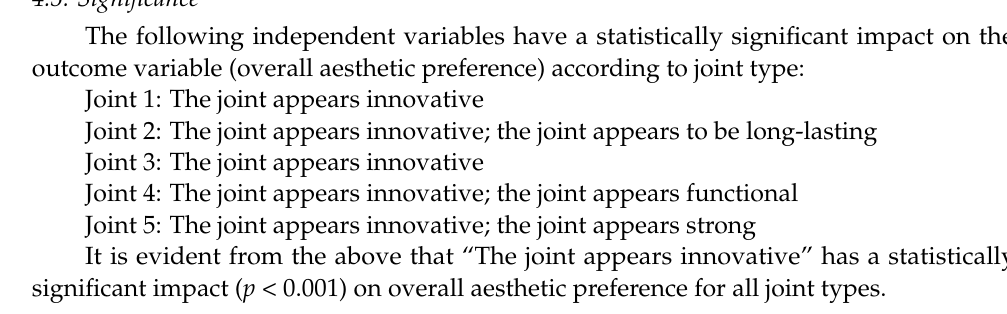
Table 3. Coefficients ( a ) of aesthetic preference of timber joints.